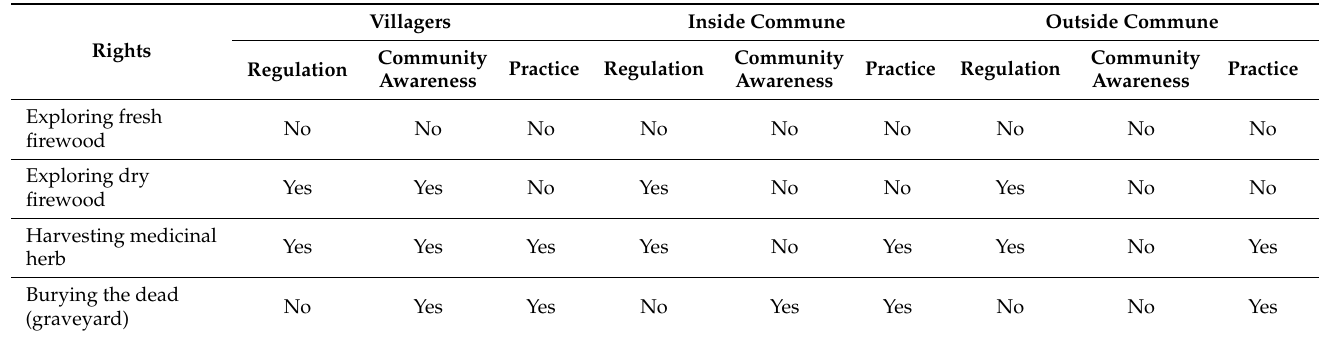
Table 5. Difference between the community’s awareness of the regulations and the sand forest management